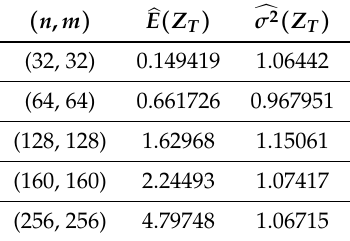
Figure 3. Distribution of the sample of 1000 values of Z T for SAC matrices generated with RC4 with n = m ∈ { 32,64,128,160,256 } . Table 9. Expected value (cid:98) E ( Z T ) and variance (cid:99) σ 2 ( Z T ) of Z T for SAC matrices generated with the RC4.